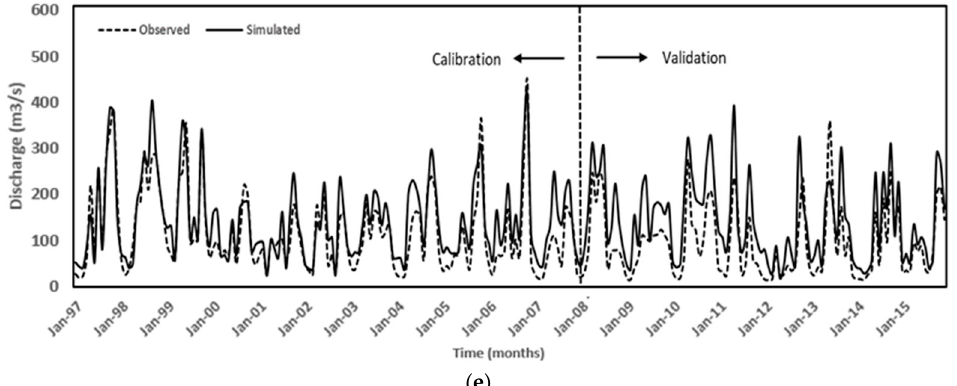
Figure 7. Monthly simulated and observed streamflow discharge for multi-site calibration: ( a ) Deraniyagala; ( b ) Kithulgala; ( c ) Holombuwa; ( d ) Glencorse; ( e ) Hanwella. Table 9. Fitted values for calibrated model